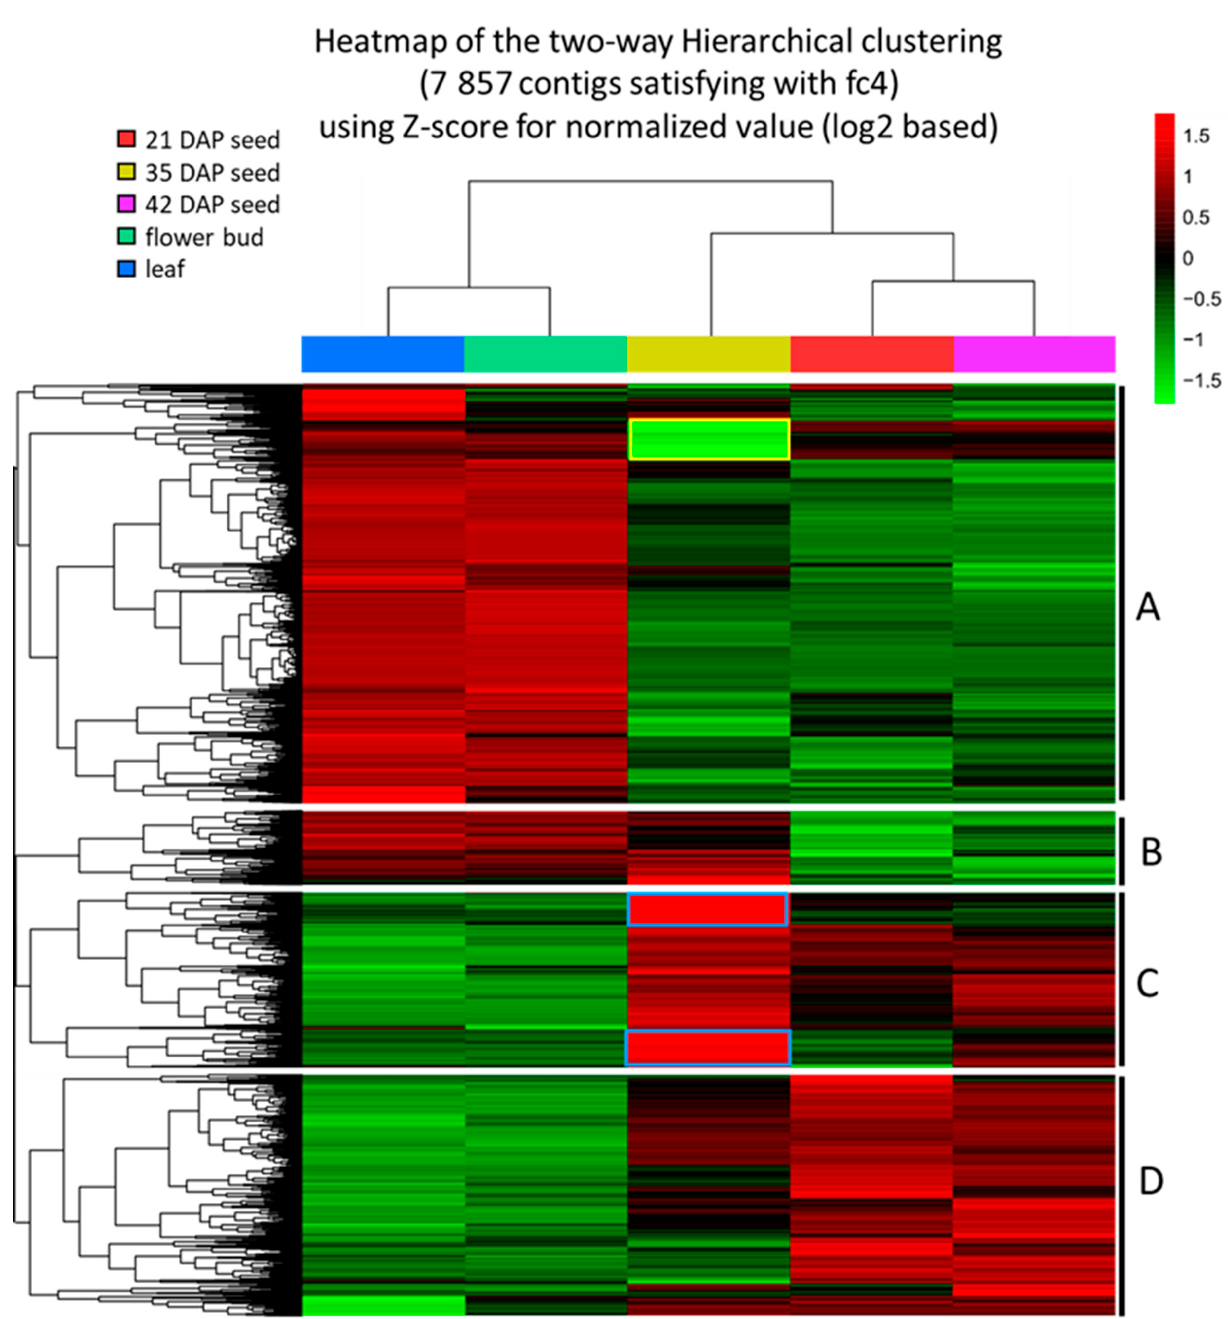
Figure 2. Heat map for hierarchical clustering. For a significant total of 7857 contigs, samples and contigs with similar expression levels were grouped by hierarchical clustering analysis (Euclidean method, complete linkage) using expression level (normalized value) for each sample and contigs. In the 35 DAP sample, yellow or blue boxes indicate that most of the contigs were highly down-regulated (green color) or up-regulated (red color). Groups A, B, C and D were visually divided. fc4, fold change ≥